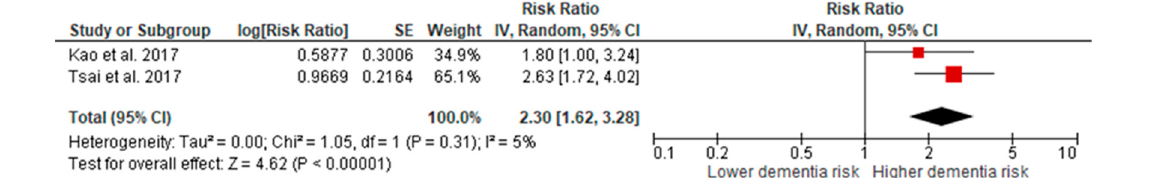
Figure 4. Risk of dementia in AKI patients with stroke .